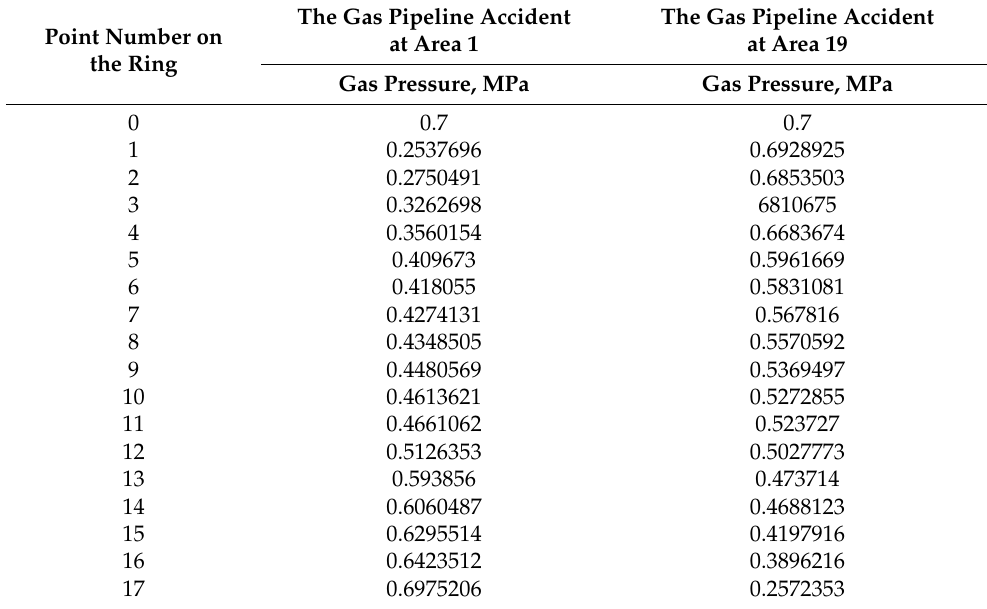
Table 6. Calculation in case of the area